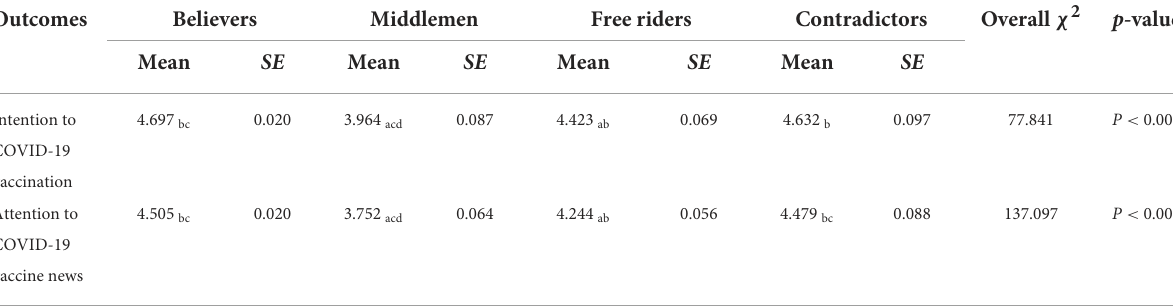
TABLE 6 Results of predicting outcomes of latent profile membership. Outcomes Believers Middlemen Free riders Contradictors Overall χ 2 Mean SE Mean SE Mean SE Intention